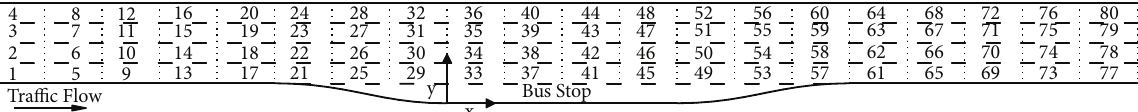
Figure 8: Schematic of the evaluation object.